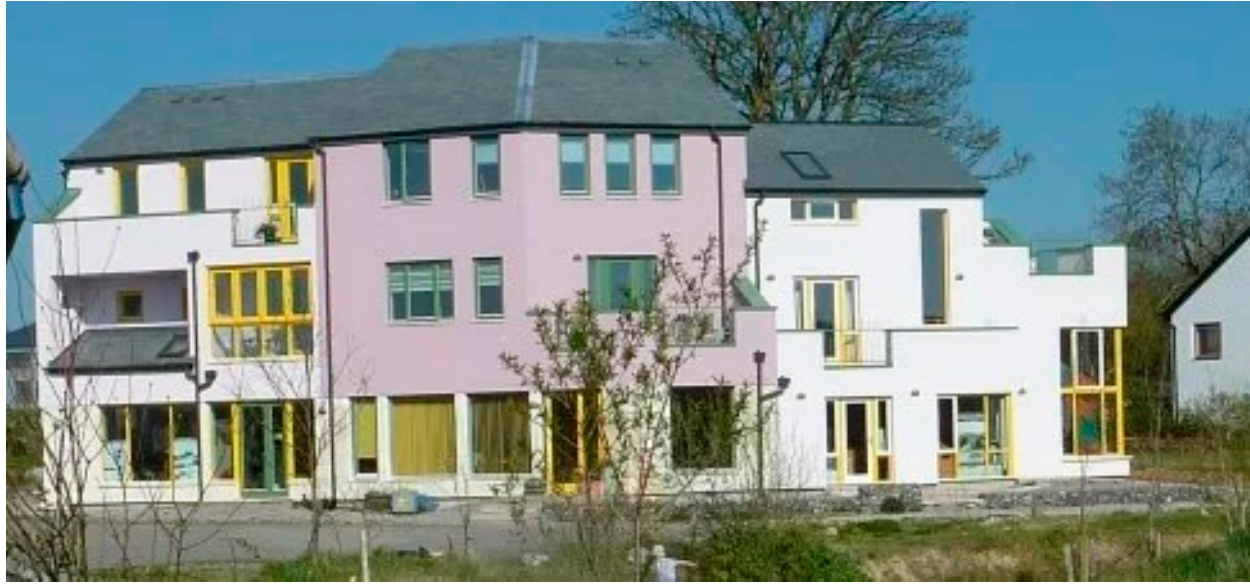
Figure 1. The An Corrán three-storey, terrace of three timber-framed residential workplace units, totalling 469 m 2 (GIFA), located in the Cloughjordan Ecovillage, Co. Tipperary, Ireland. (Source: Eoin Campbell, architect, Gaïa ecotecture).